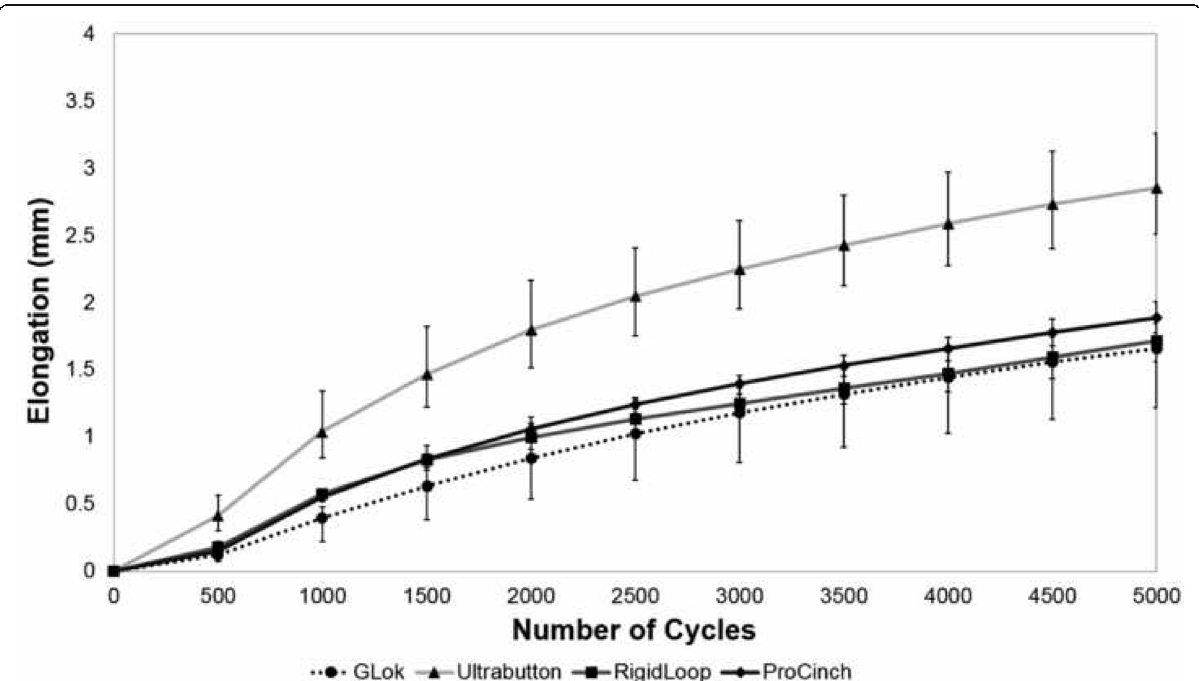
Fig. 6 Loop elongation at each cycle of the incremental cyclic loading phase for all